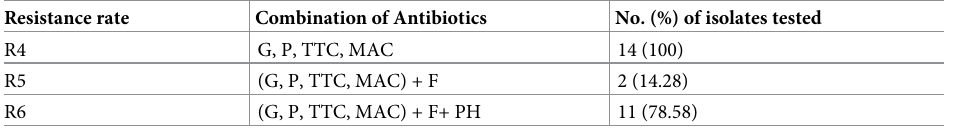
Table 3. Profile of multidrug resistance pattern of VRE isolates among clients attending ART clinic at Arba Minch General Hospital, Southern Ethiopia October 2020 (n =